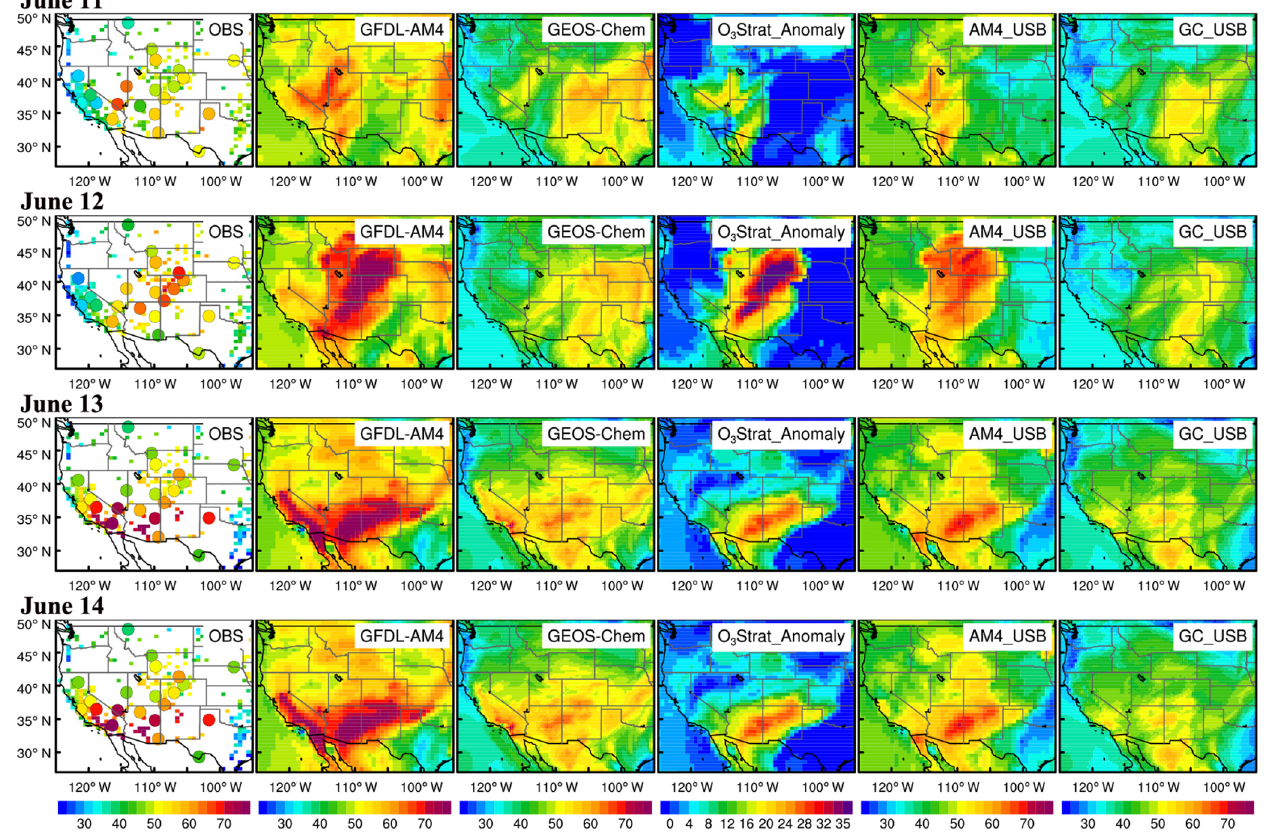
Figure 9. Maps of total MDA8 O 3 (ppbv) in surface air as observed (small squares for AQS data and large circles for CASTNet data) and simulated with GFDL-AM4 and GEOS-Chem, along with anomalies in AM4 O 3 Strat (relative to June mean) and model-estimated USB levels, during the STT event on 11–14 June 2017. Note that O 3 Strat in this figure and Fig. S6 is shown as anomalies relative to the monthly mean, while the absolute values are shown in Figs. 4 and